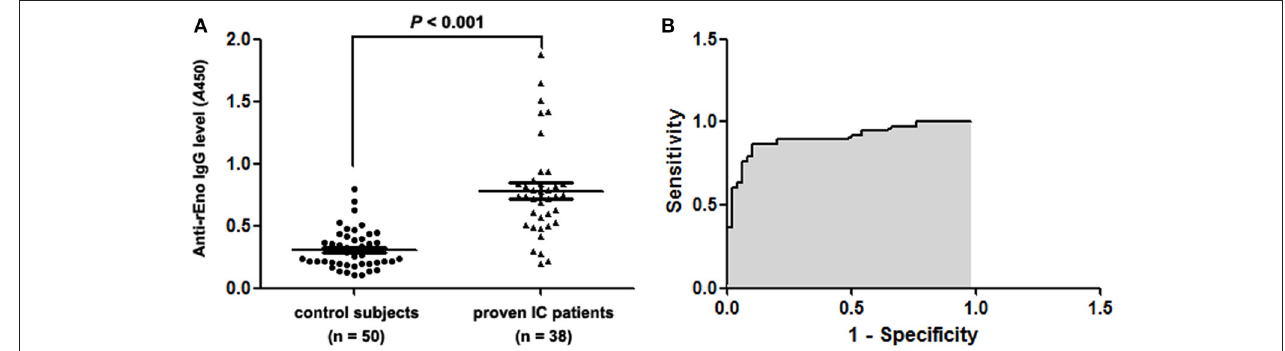
FIGURE 2 | ELISA test results for the study subjects. (A) Antibody levels in the study subjects. The anti Eno levels for the sera from IC patients were significantly higher than those in control individuals ( P < 0.001). (B) The receiver operating curve (ROC) was used to identify the anti Eno positive and negative subjects. The area under the curve (AUC) was 0.907 with a cutoff value of 0.476.